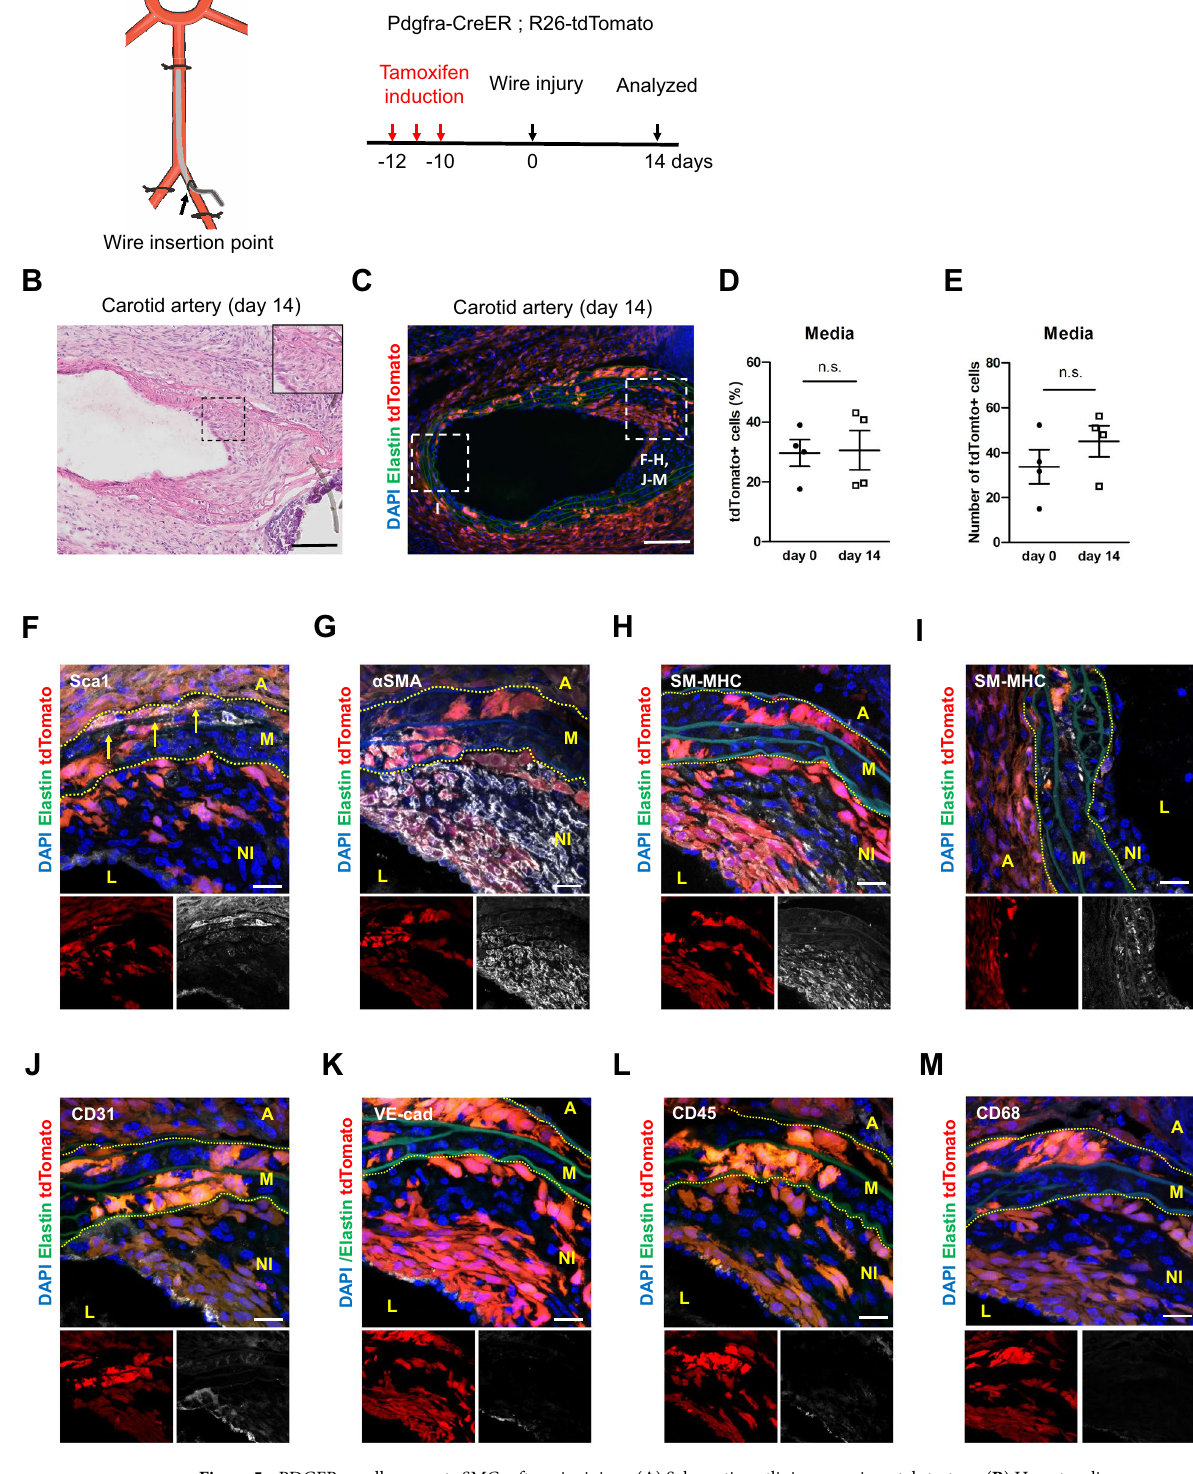
Figure 5. PDGFRa+ cells generate SMCs after wire injury. ( A ) Schematic outlining experimental strategy. ( B ) Hematoxylin eosin-stained carotid artery at 14 days after wire injury. The dotted box area is shown in the inset present an image with higher magnification. Scale bar: 100 µm. ( C ) Fluorescence image showing the distribution of tdTomato+ cells at 14 days after wire injury. Scale bar: 100 µm. ( D ) Quantification of the percentage of tdTomato+ cells in the media before and after wire injury. Data are presented as the mean ± SEM, day 0, N = 3, 14 days after wire injury, N = 4. Unpaired t-test, n.s.: not significant. ( E ) Quantification of the number of tdTomato+ cells in the media before and after wire injury. Data are presented as the mean ± SEM, day 0, N = 3, 14 days after wire